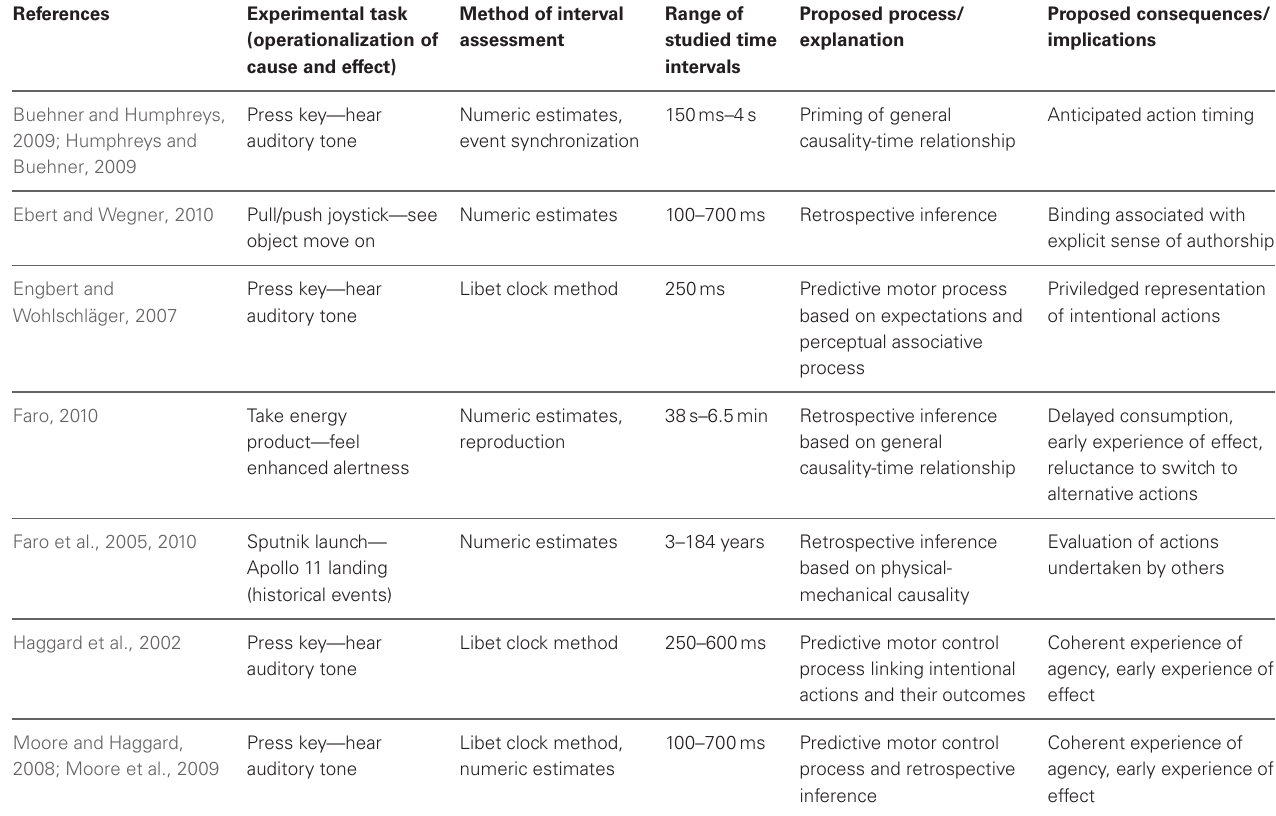
Table 1 | Summary of some studies showing an effect of causality on time